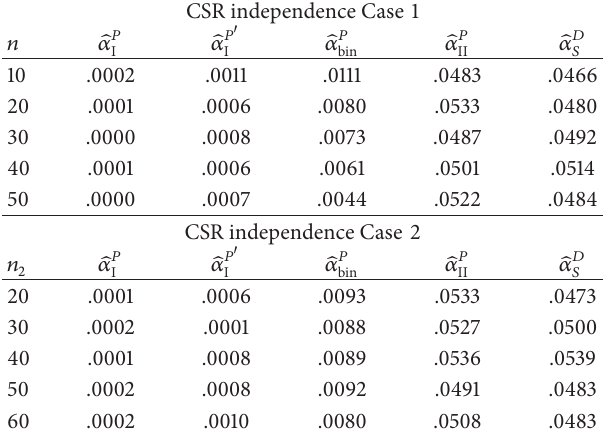
Table 3: The empirical significance levels of the symmetry tests under CSR independence Case 1: 𝑛 1 = 𝑛 2 = 𝑛 = 10,20, . . . , 50 and